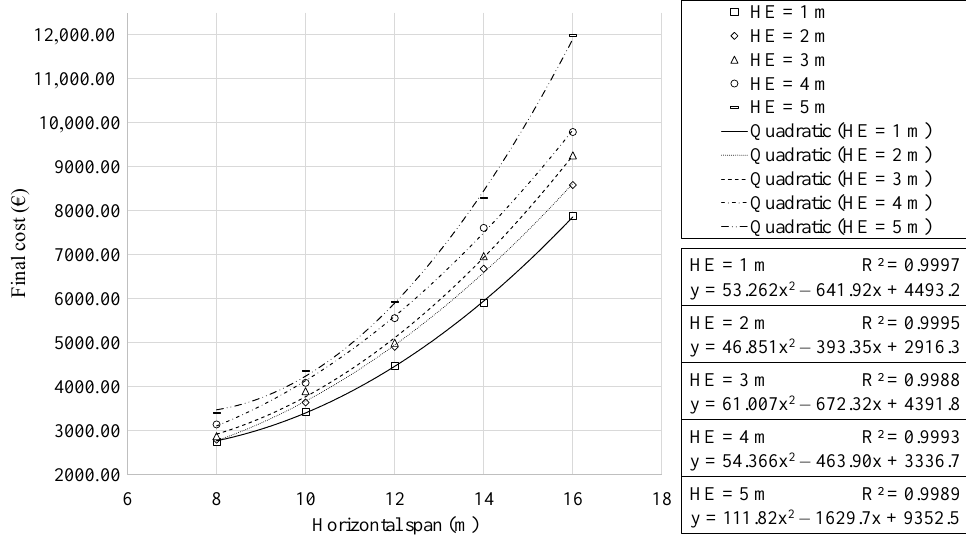
Figure 3. Cost of the RMHF as function of the horizontal span, for each earth cover